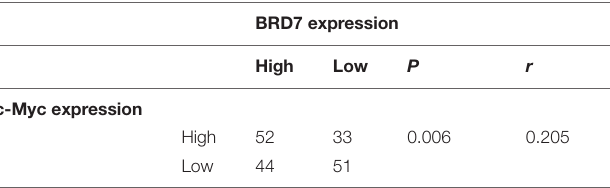
TABLE 2 | BRD7 expression were positively correlated with c-Myc expression in CRC patients ( N = 180). BRD7 expression